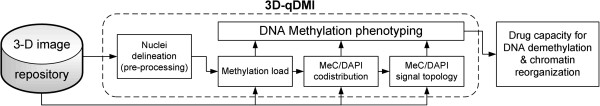
Workflow of 3D quantitative DNA methylation imaging and analysis. Image data acquired by high-resolution microscopy is subjected to a pre-processing step, in which cell nuclei (as areas of interest) are segmented, followed by DNA methylation phenotyping. This step comprises three modules, by which recorded signals in the MeC and DAPI channels are extracted for measuring: global MeC load, MeC/DAPI signal codistribution, and MeC and DAPI signal topology within the nuclear space. The retrieved information is used to assess the capacity of a drug for DNA demethylation and concurrent chromatin reorganization.